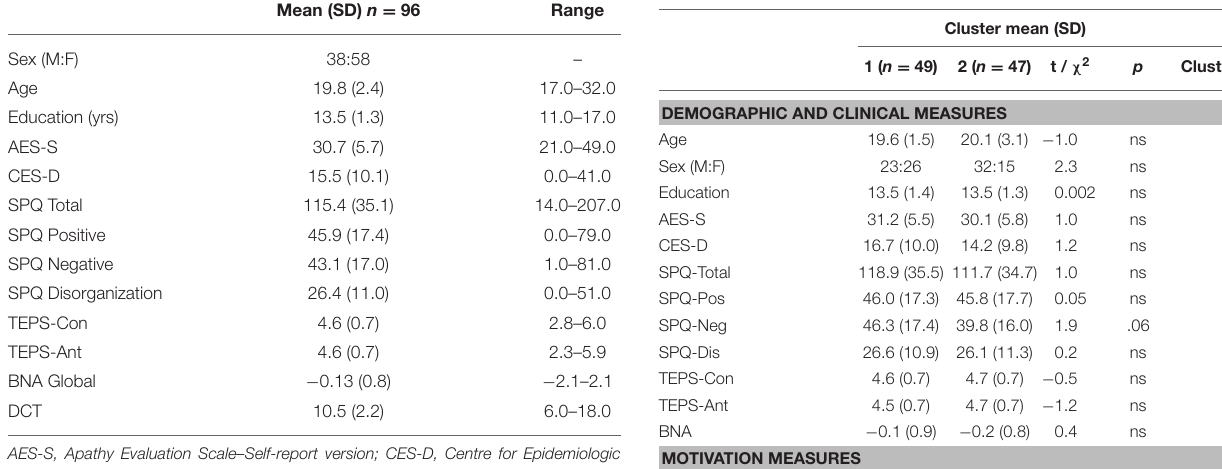
TABLE 1 | Sample demographics and symptom characterization. TABLE 2 | Demographic, clinical, and motivation performance characterization of